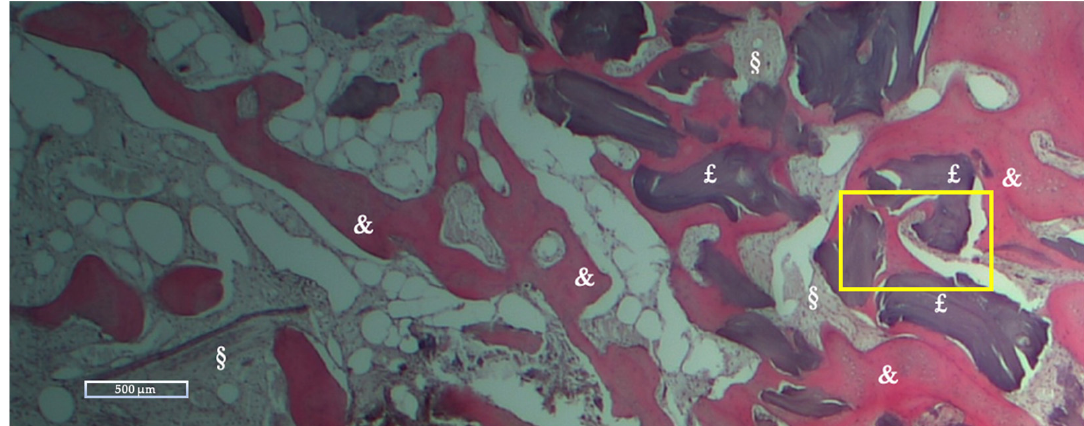
Figure 6. The regenerated tissues 8 months after the procedure stained with h&e. Graft particles are interconnected by bridges of newly formed bone (scale bar = 500 µm). Legend: £ Residual biomaterial, & Vital bone, § Soft tissue. Yellow rectangle, magnified in Figure 7.